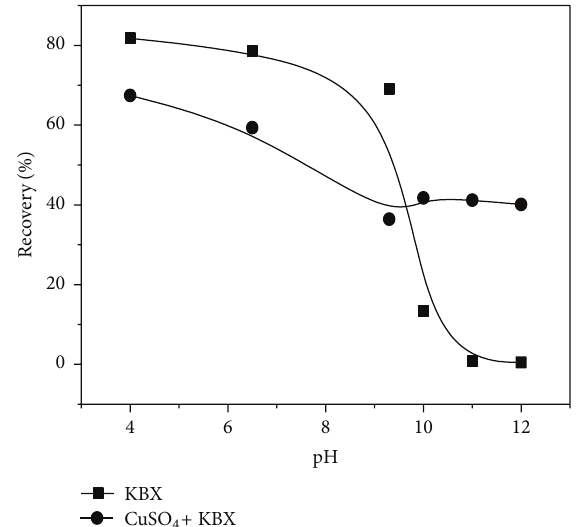
Figure1:EffectofpHonpyriteflotationintheabsenceandpresence of CuSO 4 (conditions: KBX 10mg/L; CuSO 4 : 10